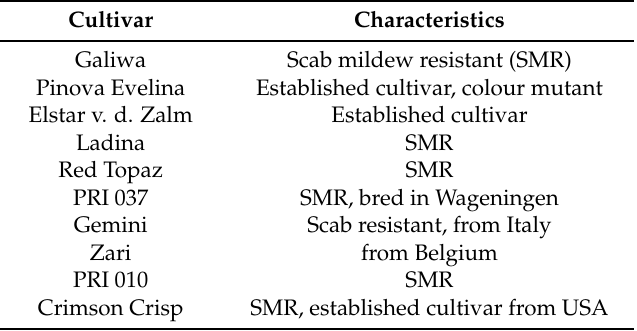
Table 1. Apple cultivars used in this